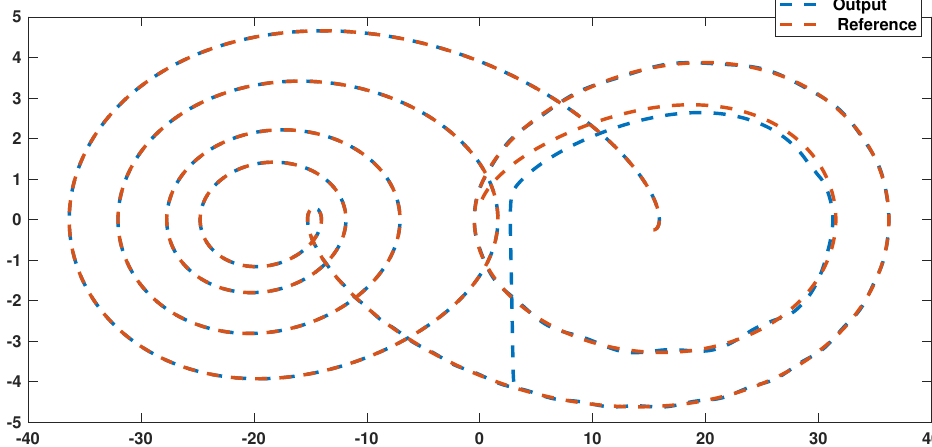
Figure 13. Example 3: Phase